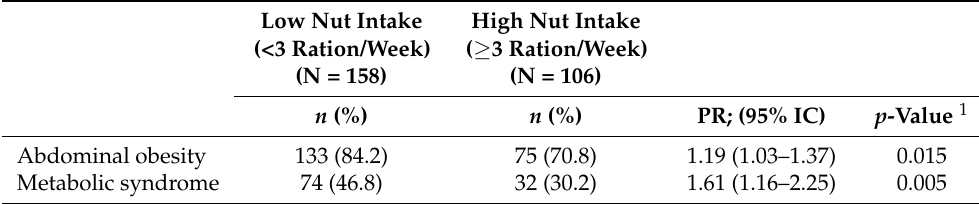
Table 3. Association between nut consumption and abdominal obesity and metabolic